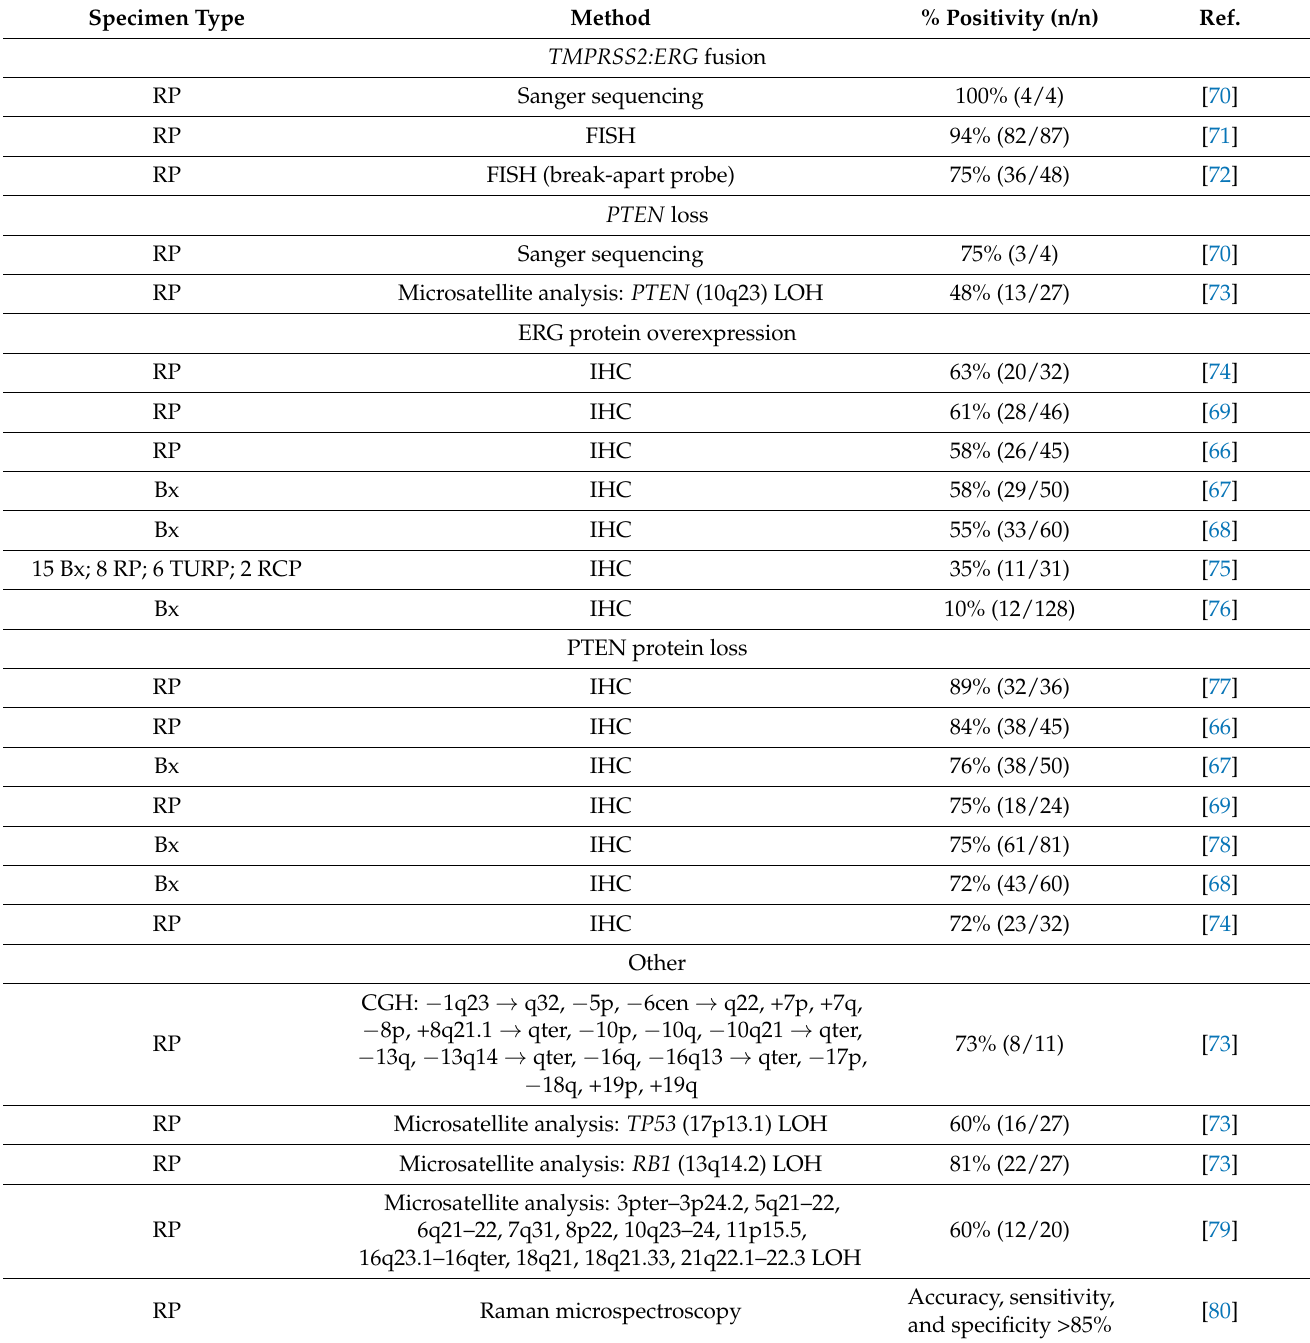
Table 2. Overview of the studies comparing IDC-P to high-grade intraepithelial neoplasia and to adjacent invasive carcinoma. Only IDC-P results are